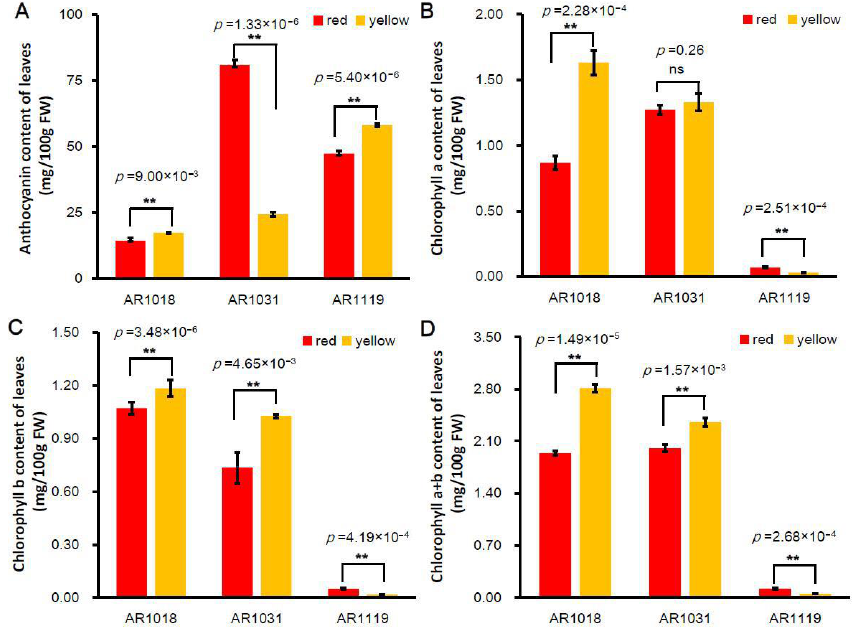
Figure 2. Pigment content of differently colored leaves in red maple. Note: ( A ) anthocyanin content, ( B ) chlorophyll-a content, ( C ) chlorophyll-b content, and ( D ) chlorophyll-a + b content (averages ± standard errors; ** p < 0.01; ns: not significant).